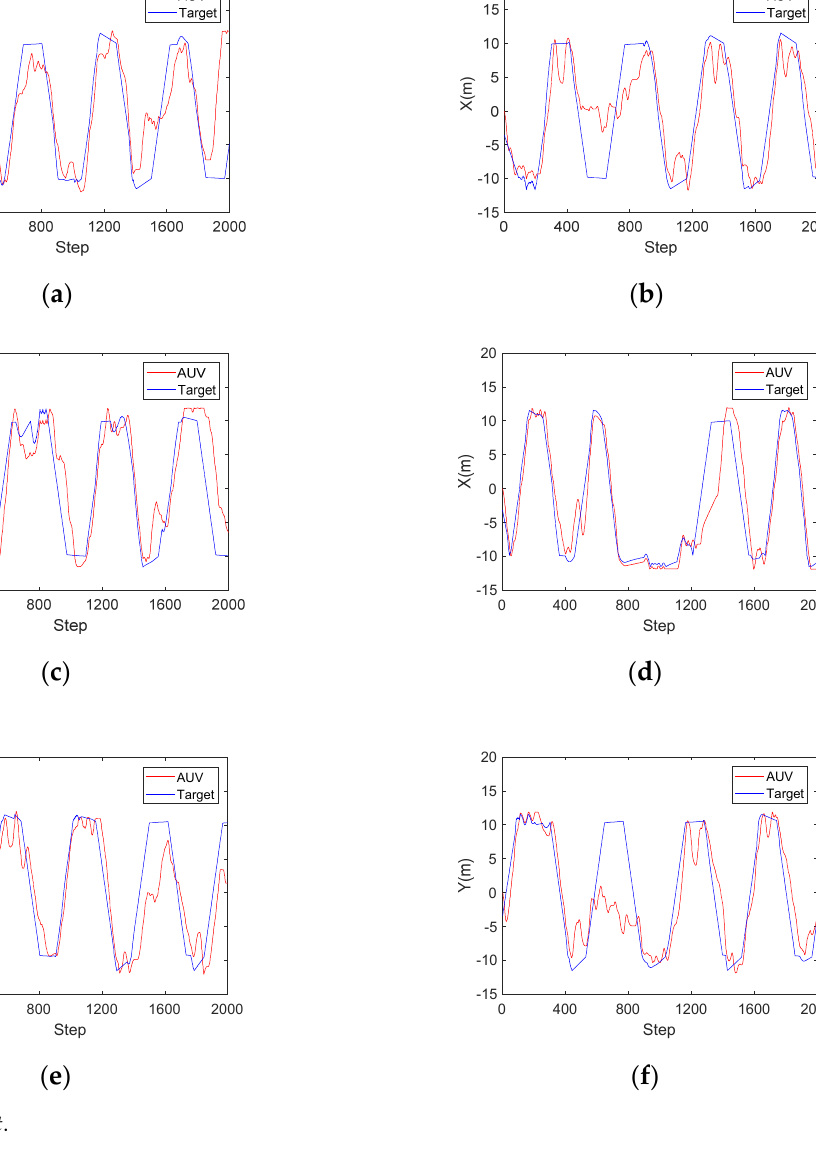
Figure 6. The coordinate change curves in Scene 1 during the process of AUV tracking the target using PPO, SAC, GAIL, and MAG, respectively: ( a – d ) the X-coordinate change; ( e – h ) the Y-coordinate change.